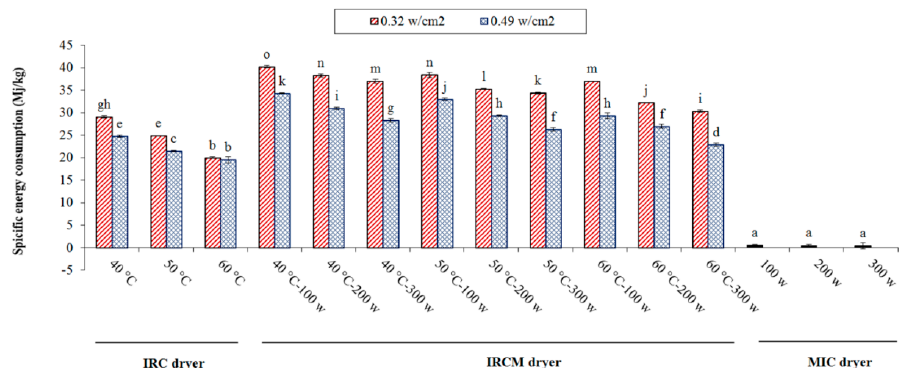
Figure 3. Specific energy consumption for rice drying under different dryers. Note: The same letter over column shows that the mean amount had no significant difference ( p < 0.05) based on Duncan’s test. The error bars represent standard error of the